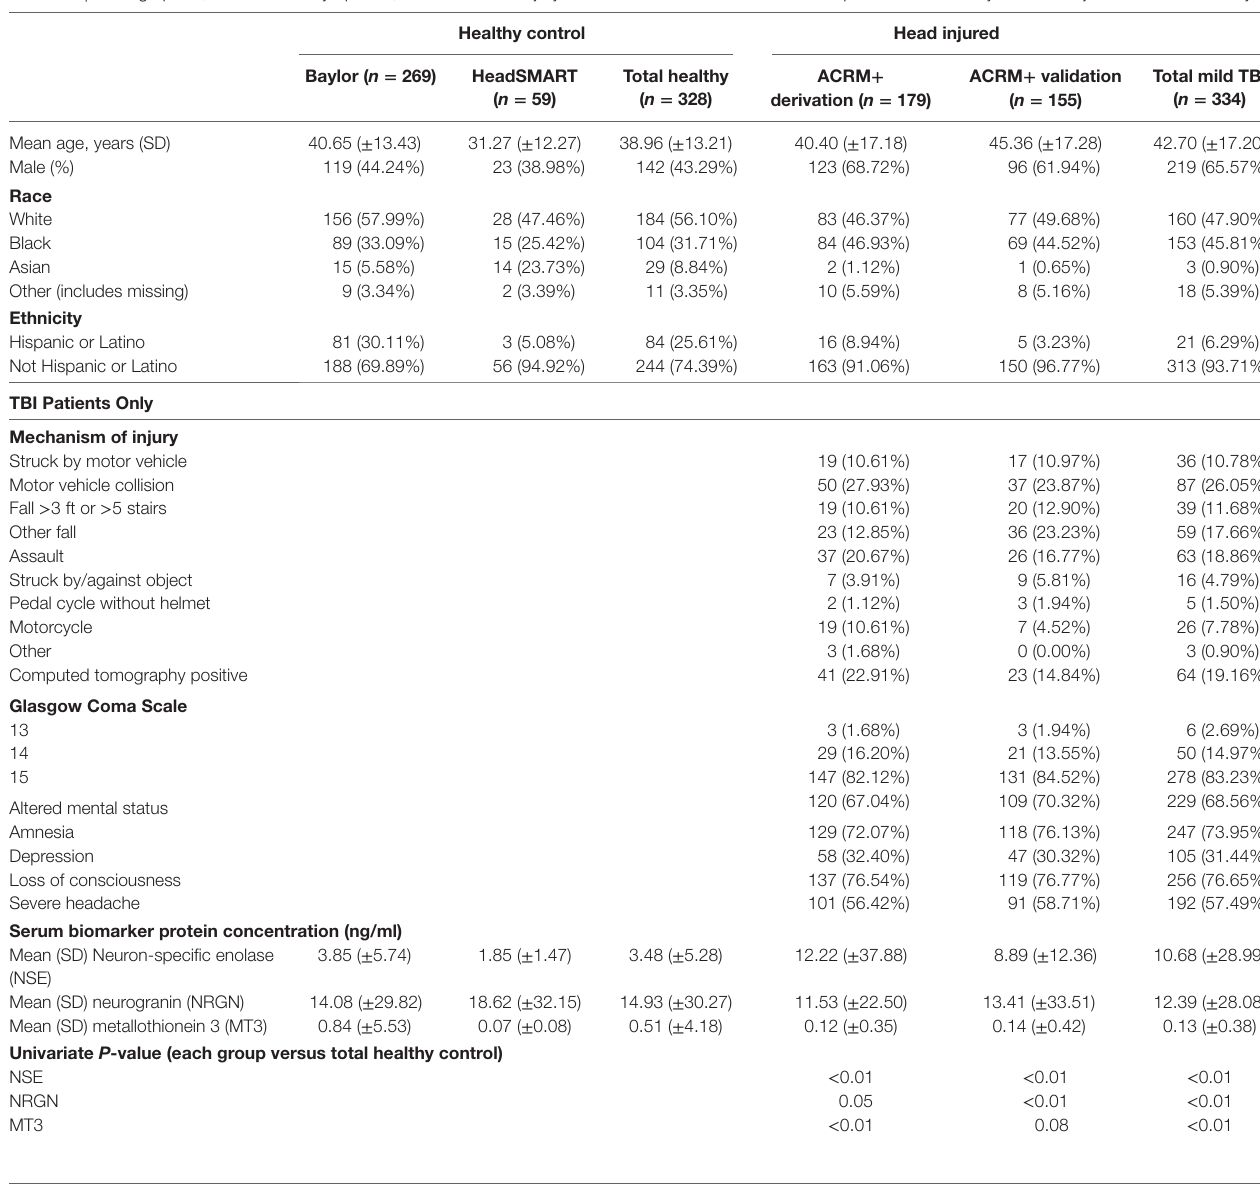
TaBle 1 | Demographics, acute clinical symptoms, mechanisms of injury and biomarker concentrations in TBI patients and healthy control subjects used in the